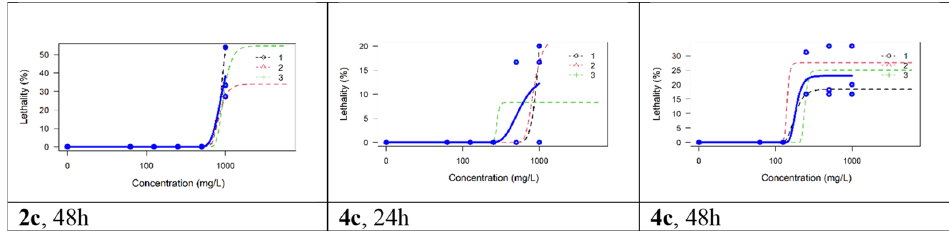
Figure 7. The lethality curves for the replicates and global models for compounds 2c and 4c . Daphnia Magna Toxicity Assay